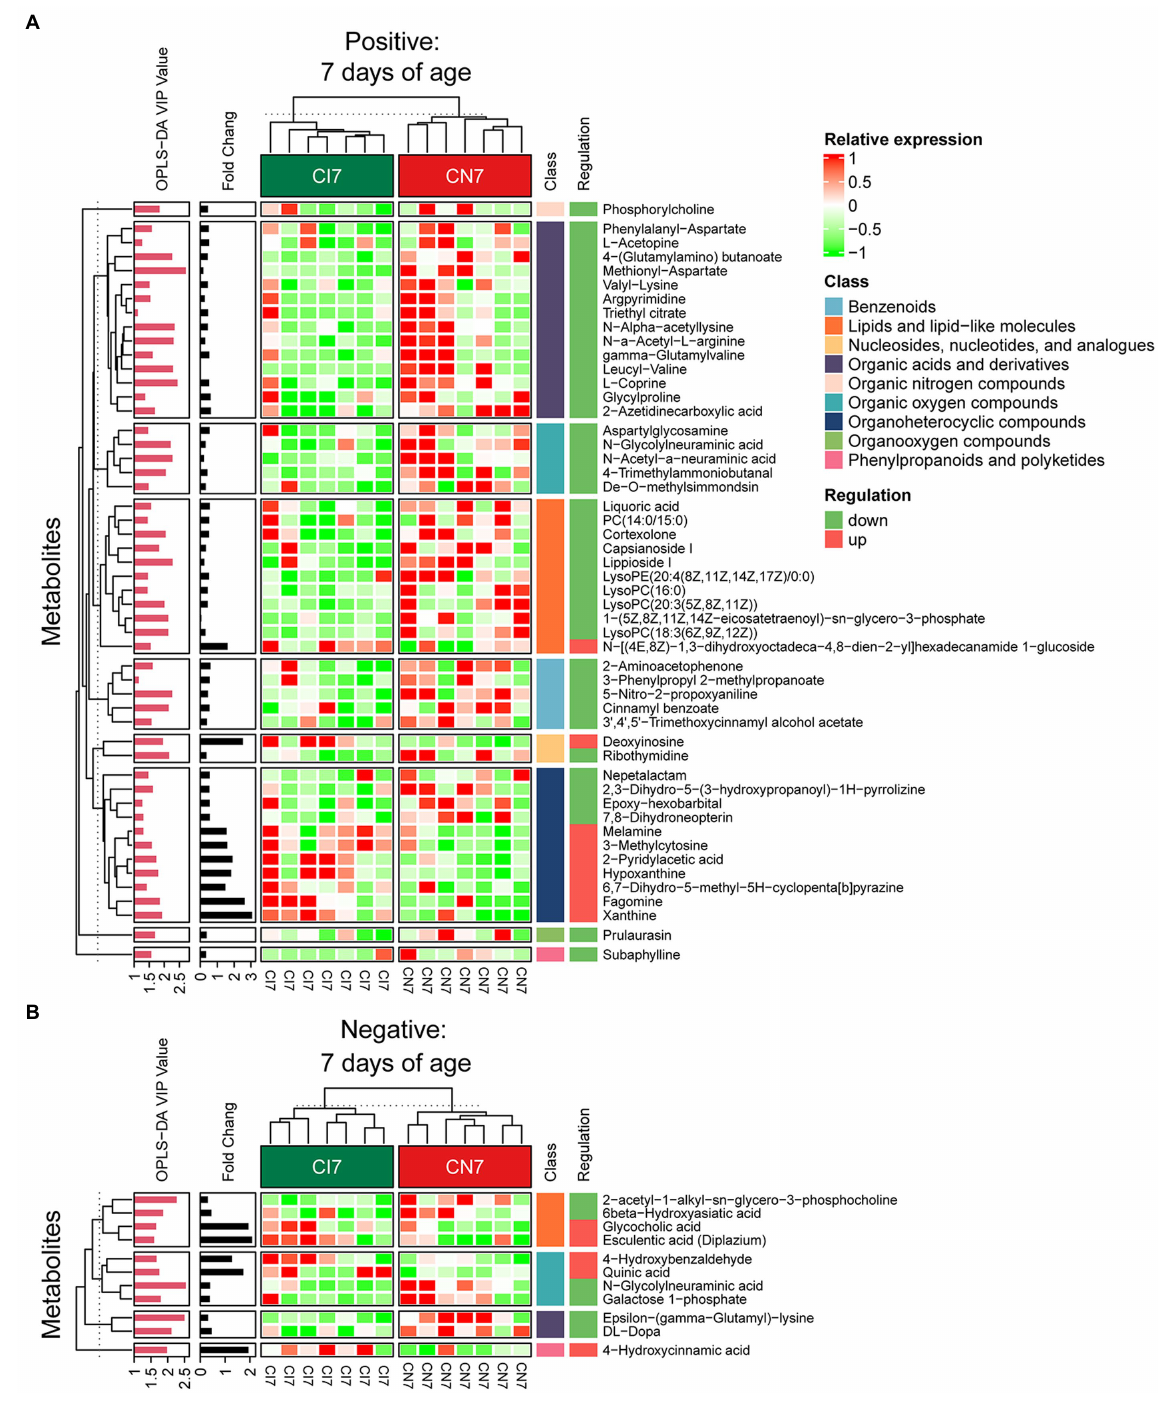
FIGURE 5 Hierarchical clustering analysis for different metabolites with MS2 based on the non-target metabolomics of the colonic contents between the intrauterine growth restriction (IUGR) and normal birth weight (NBW) piglets at 7 days of age ( n = 7). (A,B) Represent positive and negative ion models, respectively. The relative metabolite level is depicted according to the color scale. Red indicates significant up-regulation ( p < 0.05), and green indicates significant down-regulation ( p <